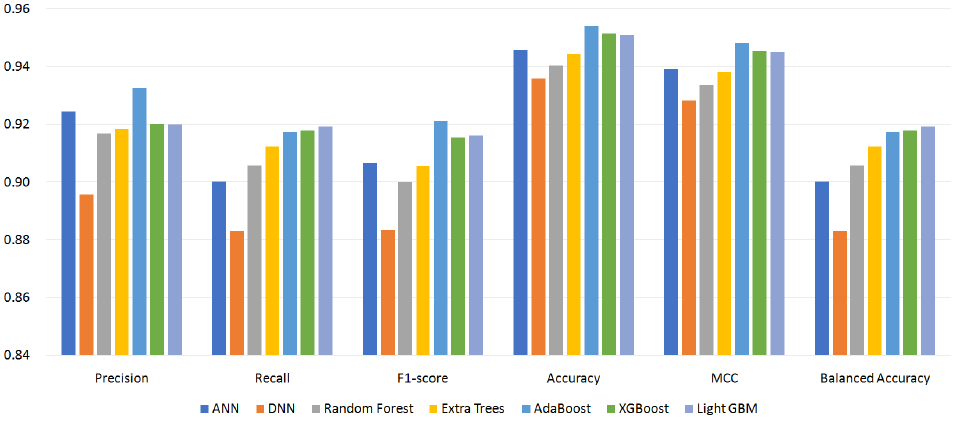
Figure 4. Performance of classifiers with permission set S96.